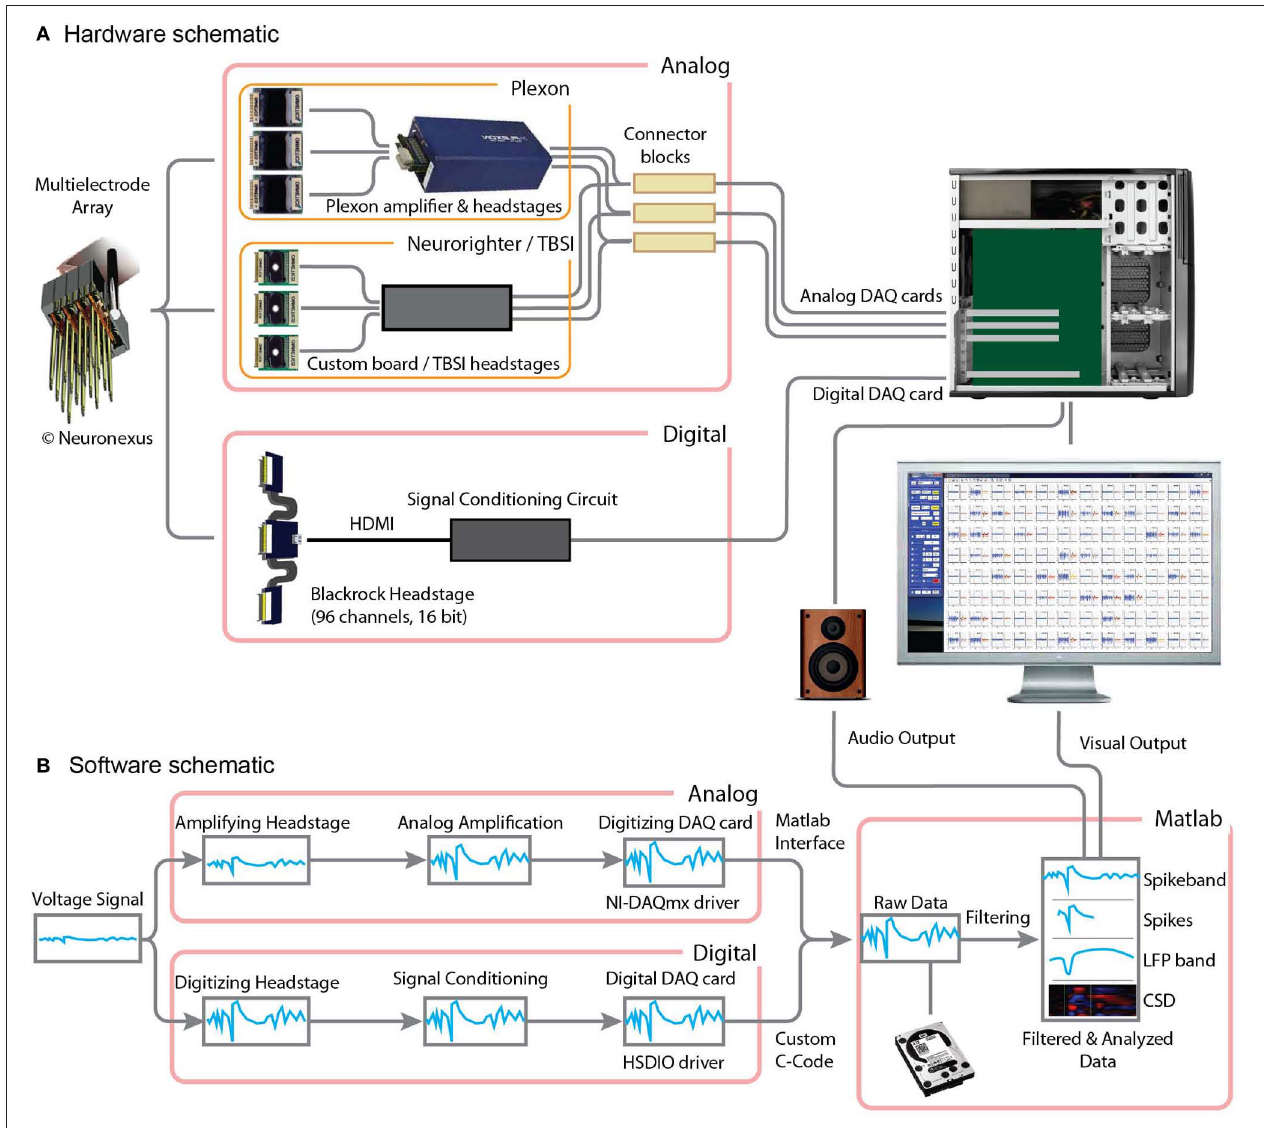
FIGURE 1 | Digital and analog recording configurations compatible with MANTA. (A) A high channel-count electrode, such as a 3D probe by NeuroNexus or a Utah array by Blackrock is connected to an analog or digital headstage. For analog headstages (top) the signal is further amplified using a second amplifier stage (e.g., Plexon or Neurorighter are shown here). The output of these systems is then routed into National Instruments DAQ cards (M- or X-series). For the digital headstage (bottom), the signal is conditioned using a special circuit (see Figure A2 ) and then digitized using a high-speed digital DAQ card by National Instruments (656X series). The signals are